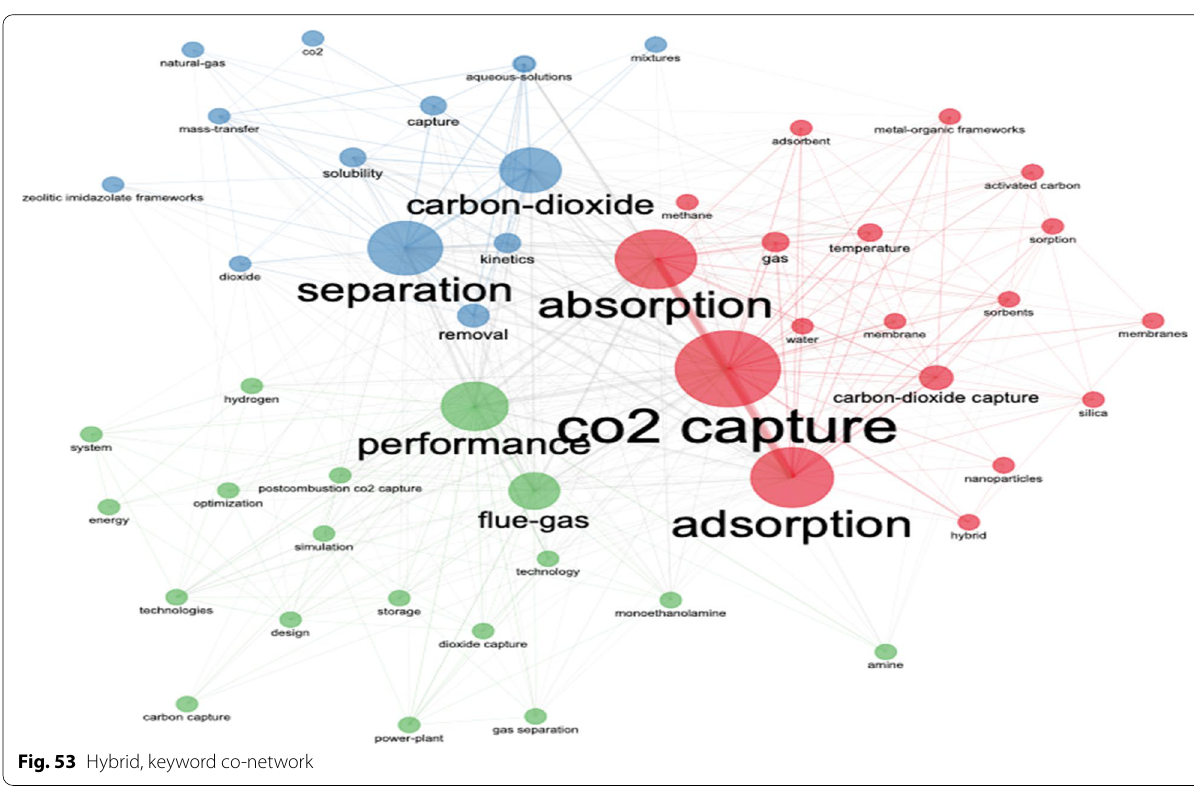
Fig. 53 Hybrid, keyword co-network